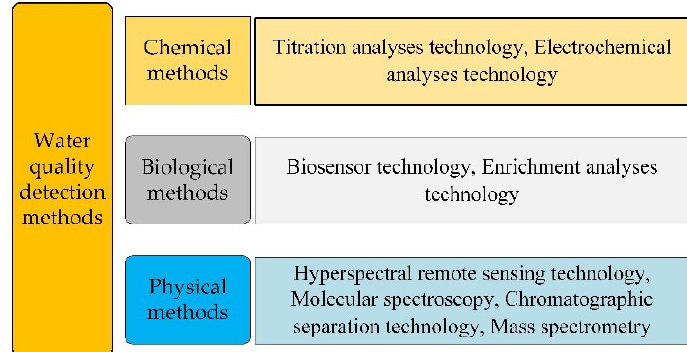
Figure 1. Methods for determining water quality.